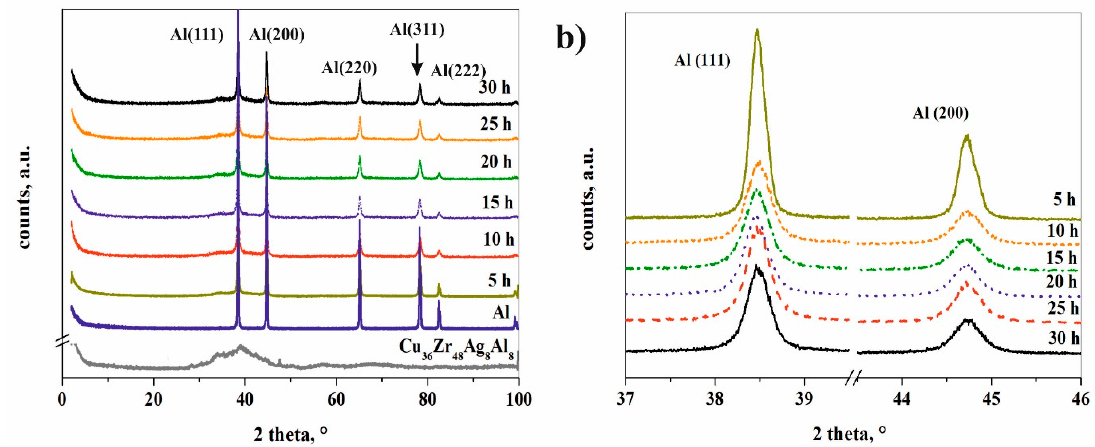
Figure 7. XRD patterns of the composite powders and initial powders ( a ) and intensity reduction of Al (111) and (200) peaks at different time intervals ( b ).